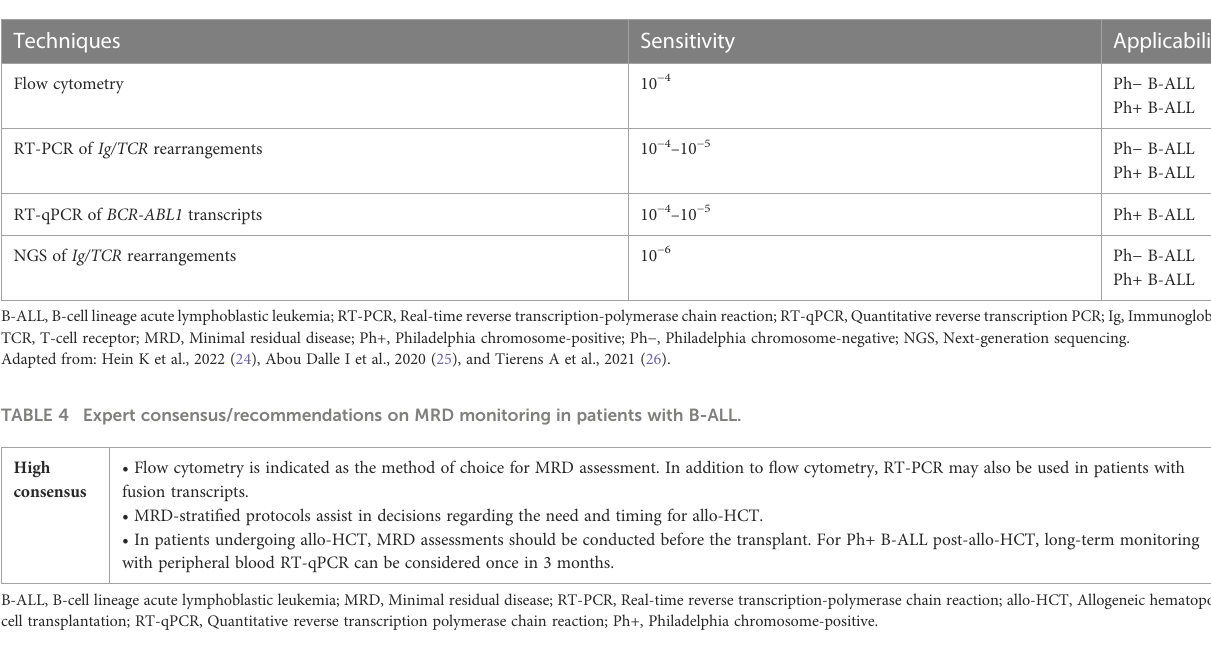
TABLE 3 Different methods for MRD assessment and level of sensitivity in patients with B-ALL.